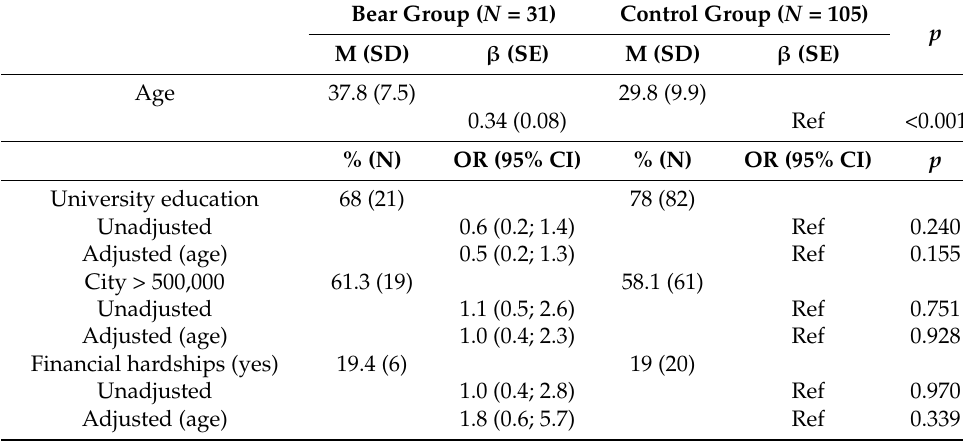
Table 1. A comparison of Bears with other gay men in terms of demographic